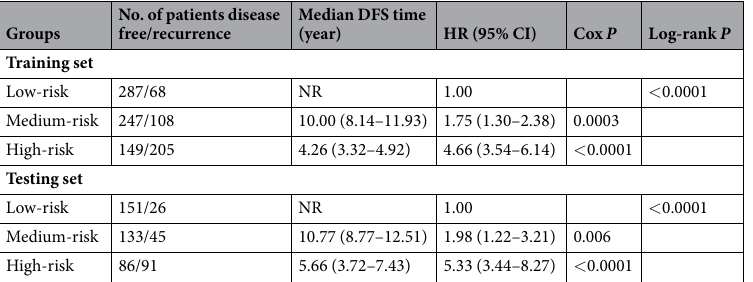
Table 4. Summary of disease free survival by risk category. Abbreviations and definitions: DFS, disease free survival; HR, hazard ratio; CI, confidence interval; NR, not